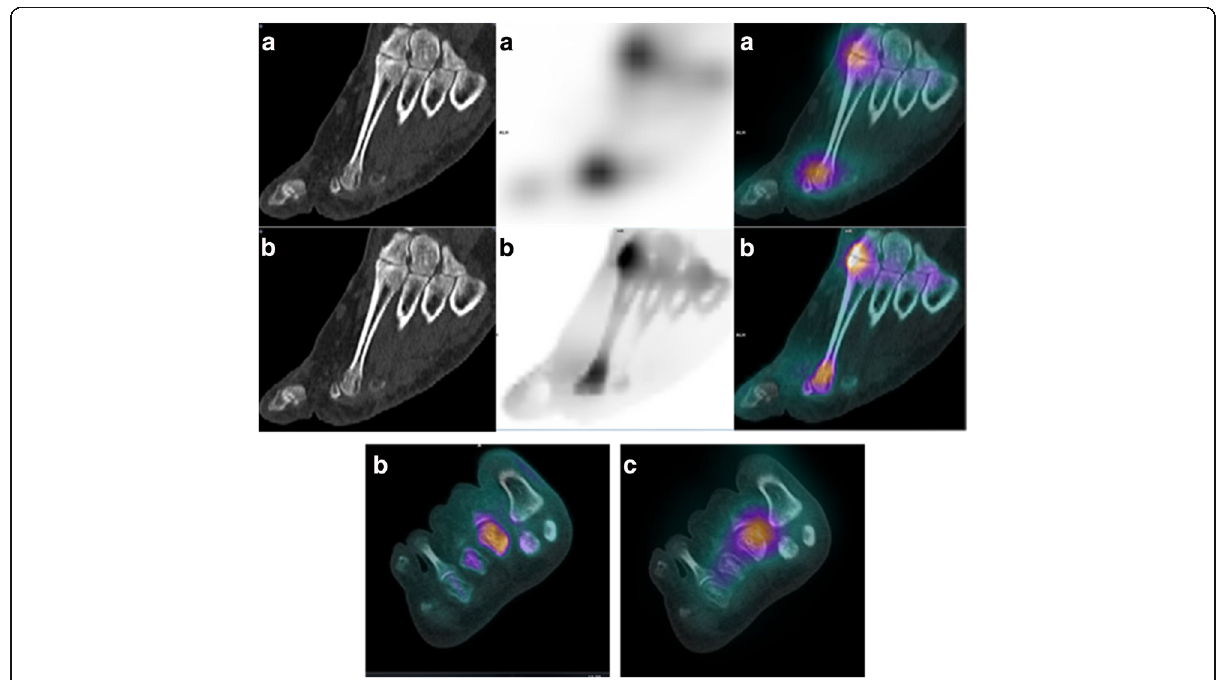
Fig. 4 Location error of xSPECT Bone® related to the movements between SPECT and CT acquisition. This SPECT/CT was performed in order to explore a foot pain with suspicion of complex regional pain syndrome. An uptake of the second metatarso-phalangeal joint is observed on the F3D image ( a ) whereas an uptake of the head of the second metatarsal is observed on the xB image ( b ). The absence of traumatic context and the evolution with painful flares for 2 years suggests an osteoarthritic origin, confirming the hypothesis evoked by F3D/CT. Moreover, we can observe on the axial slice F3D/CT ( c ) a spatial shift between F3D acquisition and CT acquisition related to the movements of the patient, causing a bad reconstruction and a localization error of